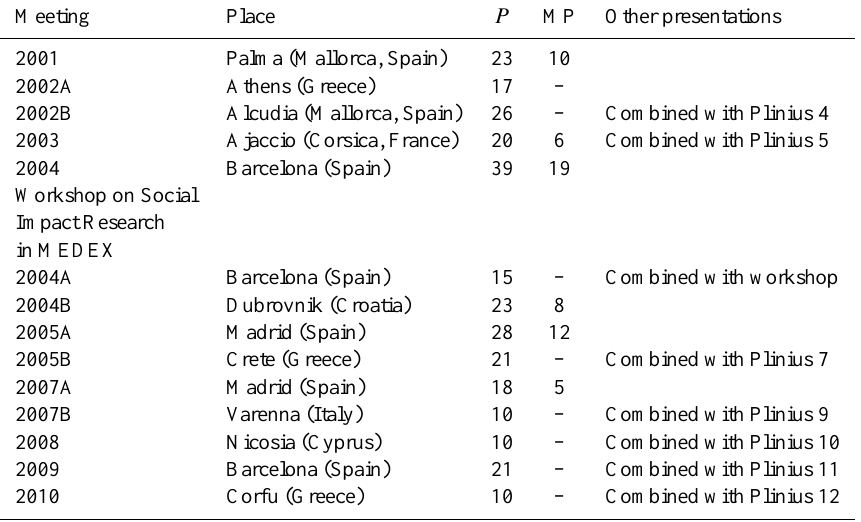
Table 1. MEDEX meetings and associated scientific presentations ( P = number of participants; MP = specific MEDEX presentations).